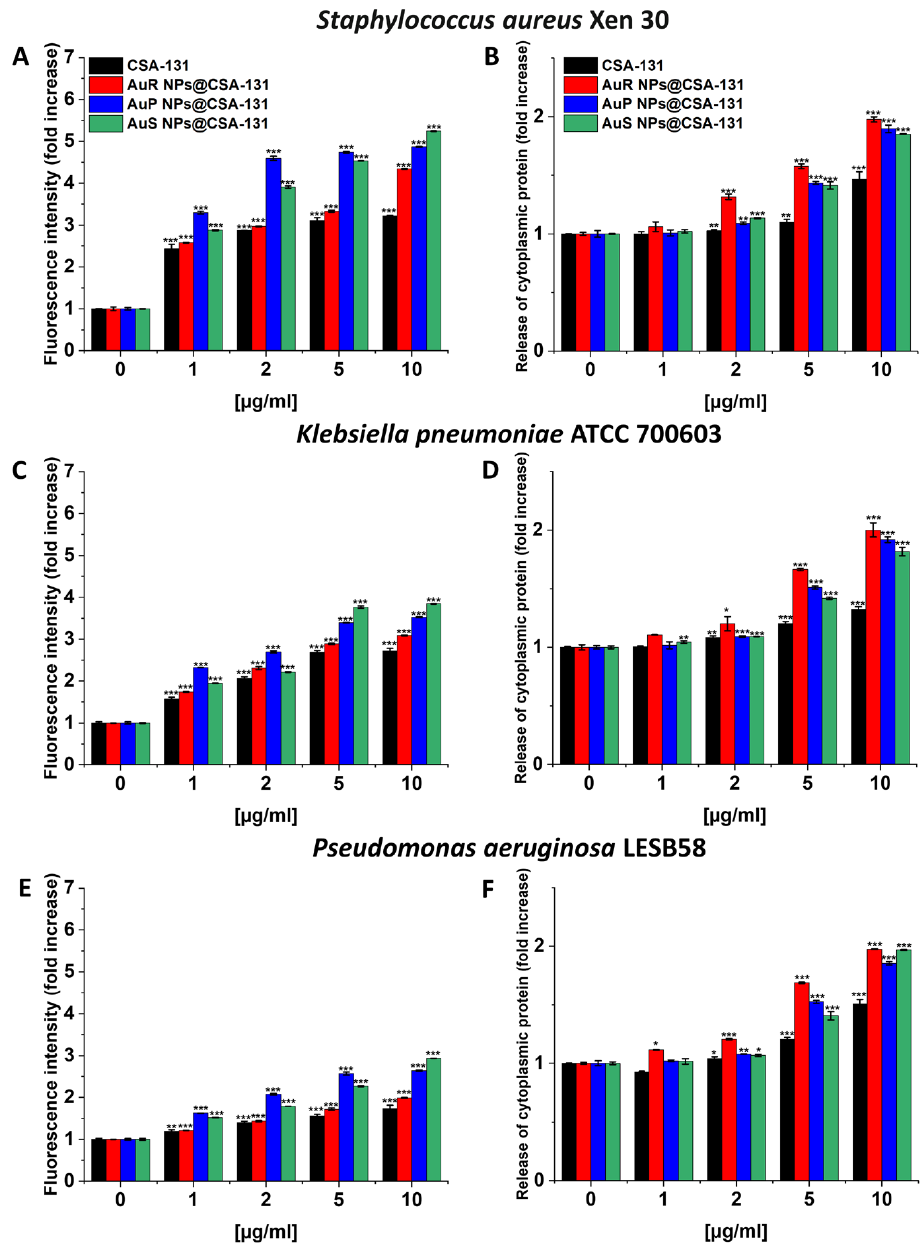
Figure 2. Bacterial membrane depolarization of multidrug-resistant strains: Staphylococcus aureus Xen 30 ( A ), Klebsiella pneumoniae ATCC 700603 ( C ), Pseudomonas aeruginosa LESB58 ( E ), was assessed using the 3,3′ -dipropylthiadicarbocyanine iodide (diSC (3) ) assay, where bacterial cells were treated with gold nanosystems functionalized with ceragenin CSA-131 with rod-shaped (AuR NP@CSA- 131), peanut-shaped (AuP NP@CSA-131), and star-shaped (AuS NP@CSA-131) metal cores and free ceragenin CSA-131. The release of cytoplasmic proteins from the bacteria Staphylococcus aureus Xen 30 ( B ), Klebsiella pneumoniae ATCC 700603 ( D ), Pseudomonas aeruginosa LESB58 ( F ), treated with AuR NP@CSA-131, AuP NP@CSA-131, AuS NP@CSA-131 and CSA-131 was assessed using the Bradford protein assay. Concentrations of the tested compounds ranged from 1–10 µg/mL. Results show the mean ± SD, n = 3; * indicates statistical significance at p ≤ 0.05, ** ≤ 0.01, and *** ≤ 0.001. Adapted from Pharmaceutics